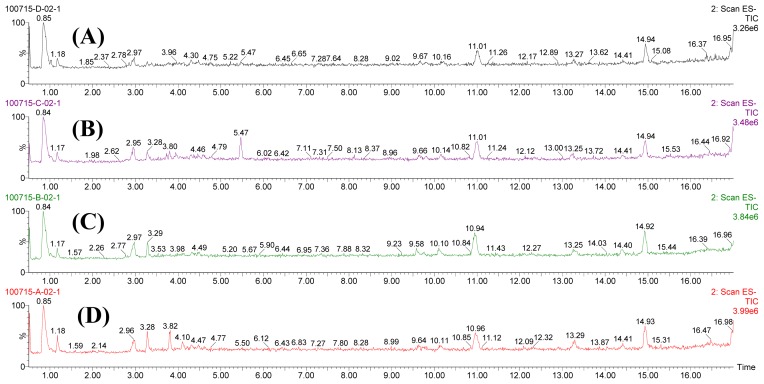
UPLC-MS total ion chromatogram of the serum samples from (A) the CCl4-induced acute liver injury rat models (CCl4); (B) Radix Paeoniae Rubra (RPR)-treated group; (C) Radix Paeoniae Alba (RPA)-treated group, and (D) the control (VEH) group after 24 h of CCl4 or olive oil injection.